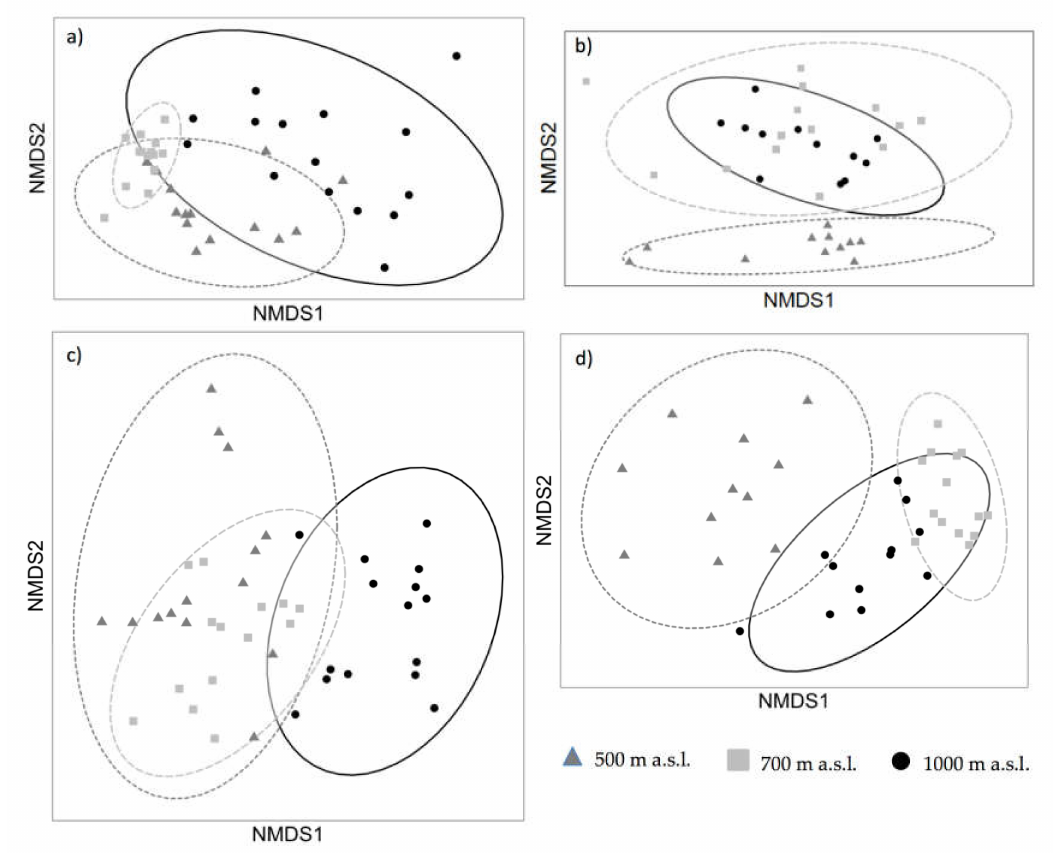
Figure 5. Two-dimensional non-metric multidimensional scaling (NMDS) plots of SOC and its distribution in WEOC, FA-C, HA-C and NEOC fractions for the soils under broadleaf ( a ) and pine ( b ) forests, and NMDS plots of Σ CO2-C, Cmic, Σ CO2-C:WEOC ratio, Σ CO2-C:Cmic ratio and Cmic:SOC ratio for the soils under broadleaf ( c ) and pine ( d ) forests, respectively, at 500, 700 and 1000 m a.s.l., Mount Cucco massif (Central Apennines, Italy). Circle lines in NMDS plot are 95% confidence ellipses. SOC: soil organic carbon; WEOC: water-extractable organic carbon; FA-C: fulvic acid carbon; HA-C: humic acid carbon; NEOC: non-extractable organic carbon; Σ CO2-C: cumulative basal respiration; Cmic: microbial biomass